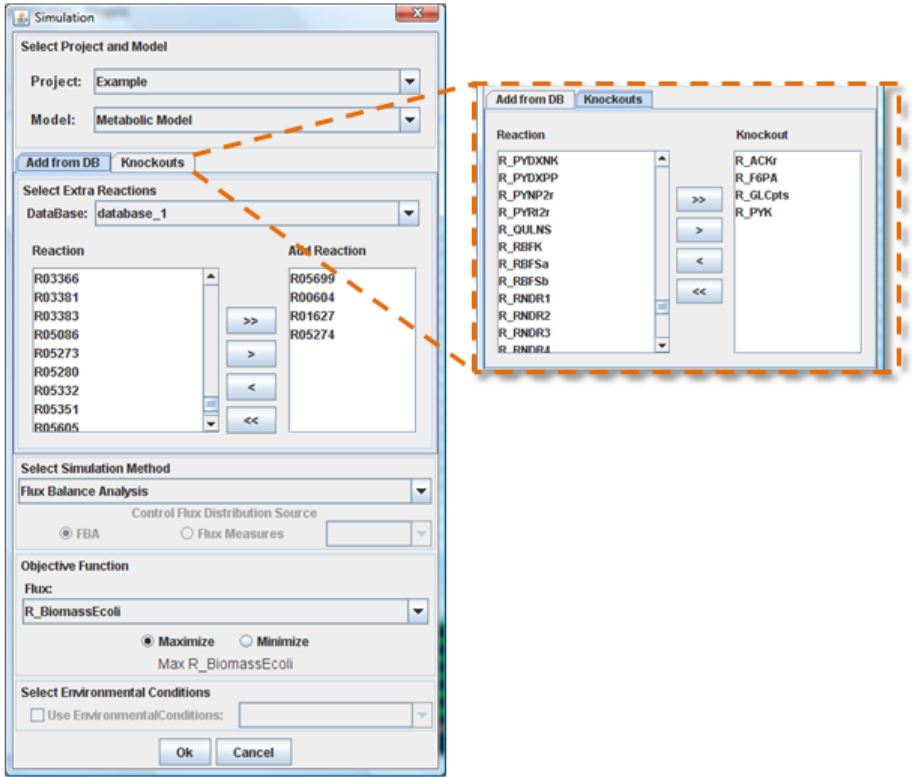
Figure 4: Interface for mutant simulation. The case study of vanillin production is shown here (see below). In the example, 4 knockouts and 4 added reactions are